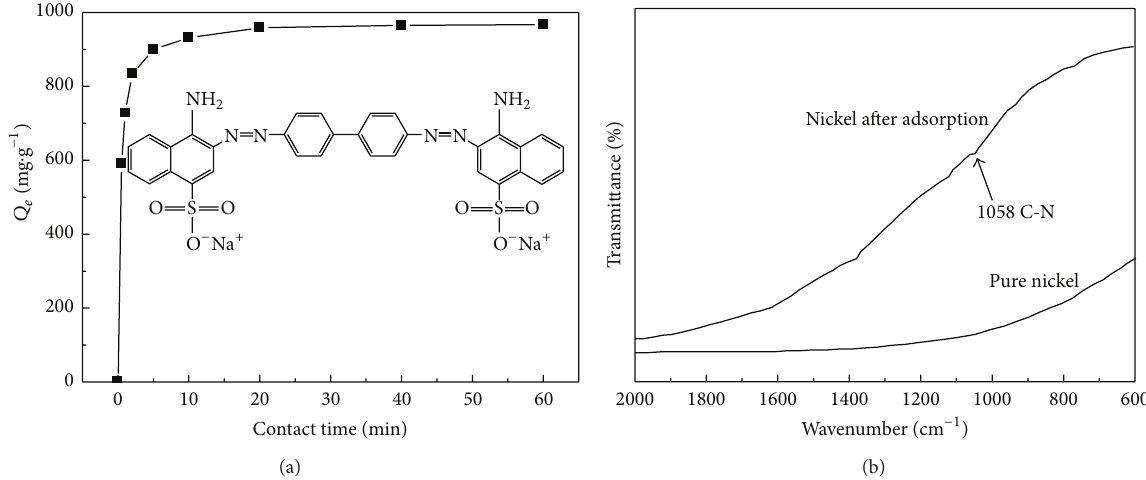
Figure 3: (a) Curve of adsorption capacities of Ni nanoparticles for CR and (b) FT-IR spectra of Ni nanoparticles before and after adsorption. Inset is the molecular structure of CR.